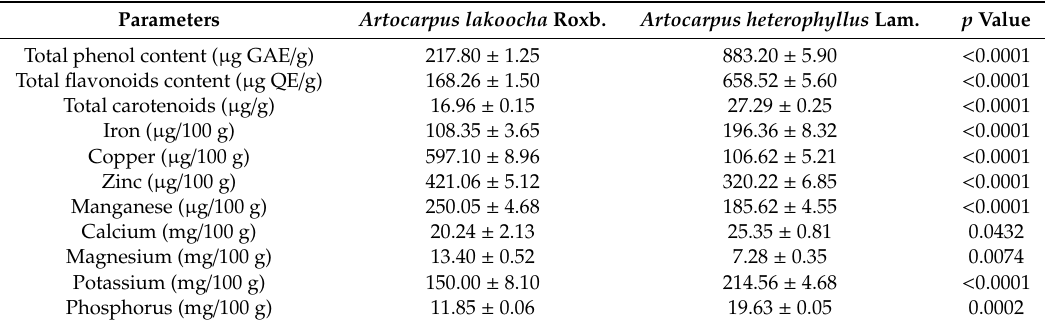
Table 1. Antioxidant and mineral components of flowers.